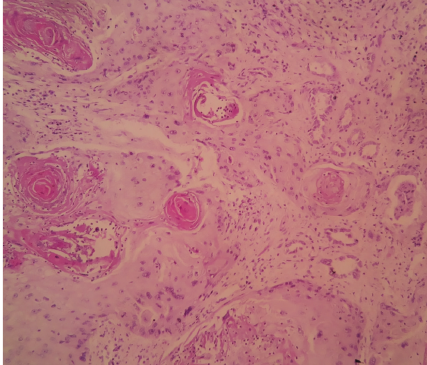
Figure 4: Normal tubular structures entrapped within the squa- mous cell carcinoma focus showing characteristic squamous